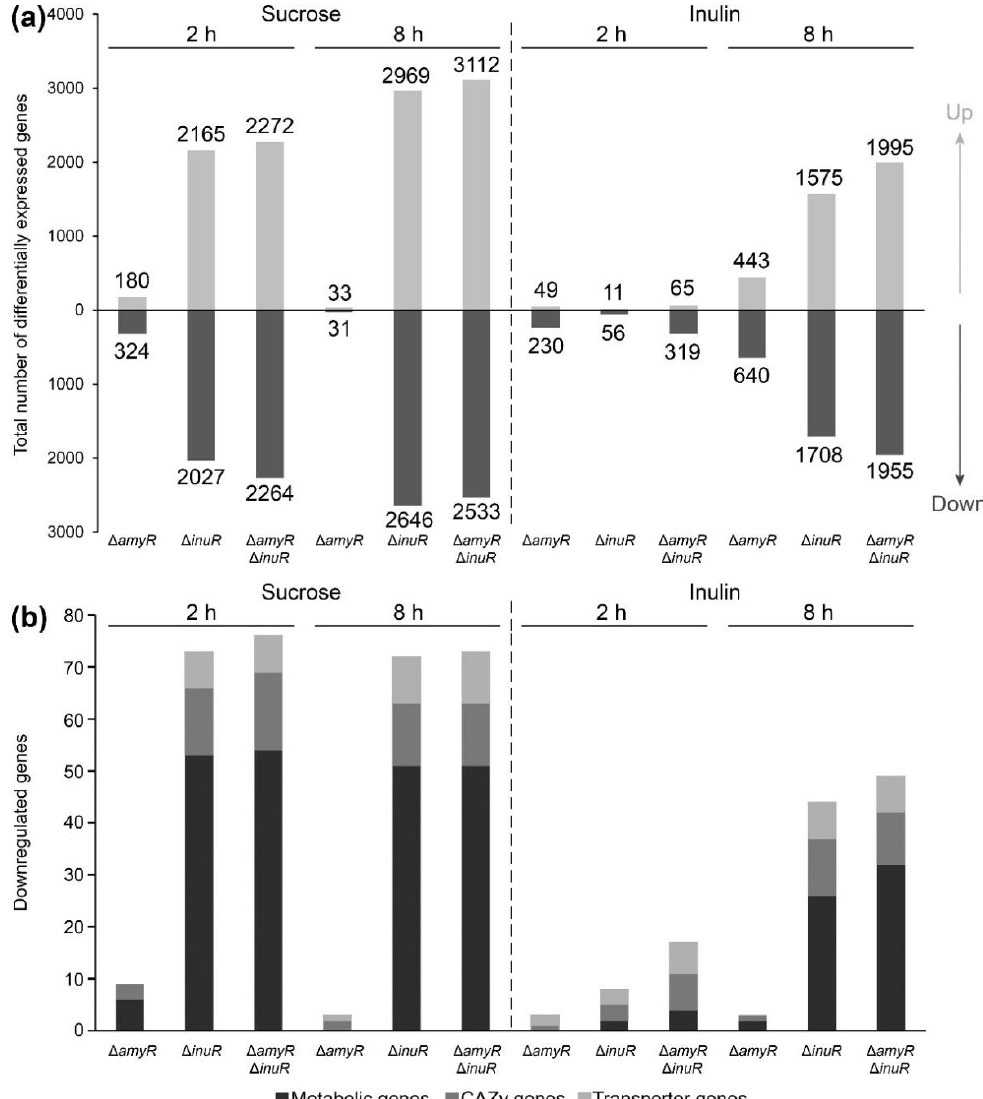
Figure 4. Differentially expressed genes (DEGs) in A. niger Δ amyR , Δ inuR and Δ amyR Δ inuR liquid cultures compared to the control (CBS 138852). Samples originated from 2 or 8 h of growth in liquid minimal medium containing 1% sucrose or 1% inulin as carbon source. ( a ) Total number of DEGs across the genome. Up- or downregulated genes are indicated by different tints of grey. ( b ) Downregulated plant biomass utilization-related genes. CAZy, metabolic and transporter genes are indicated by different tints of grey.